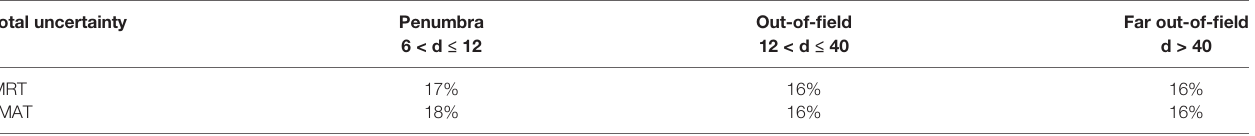
Distance d to isocenter is expressed in